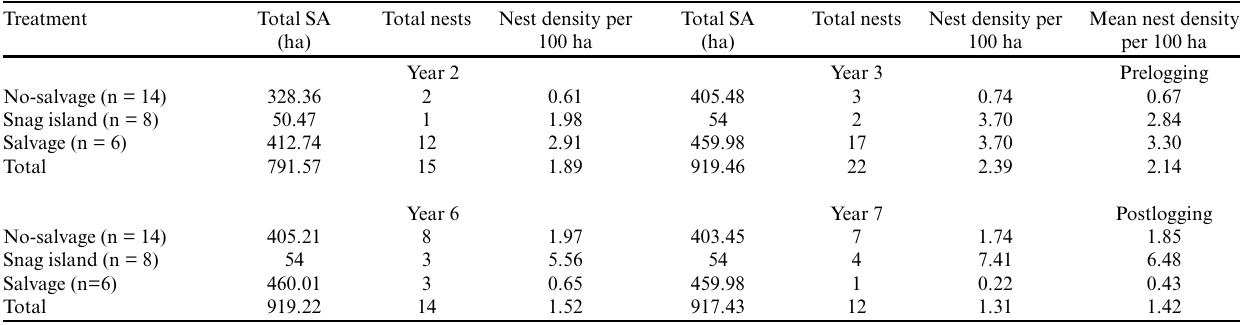
Table 1 . Search area (SA) and number of nests by time since fire and treatment. Treatment Total SA